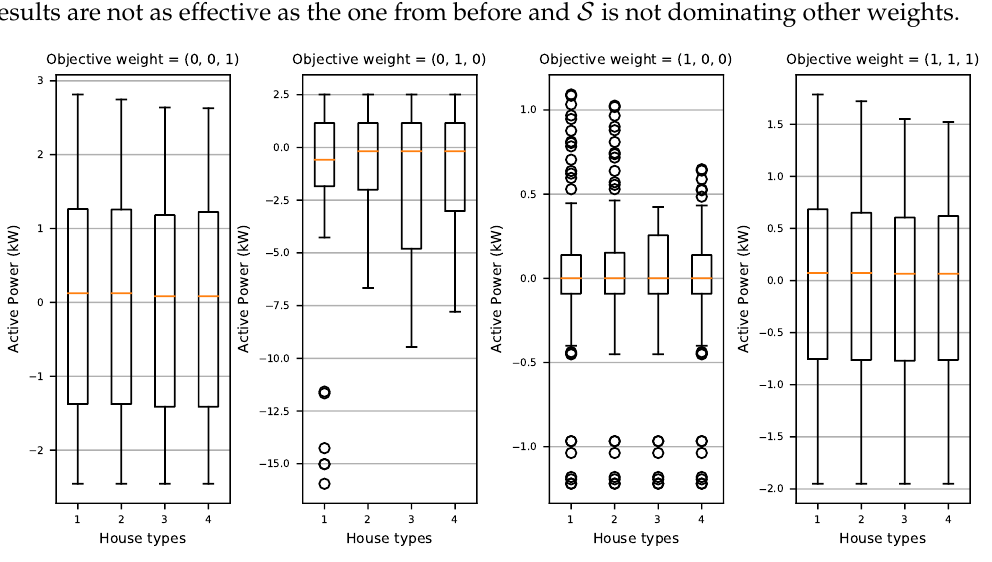
Figure 8. Schematic of Three-Phase HEMS.